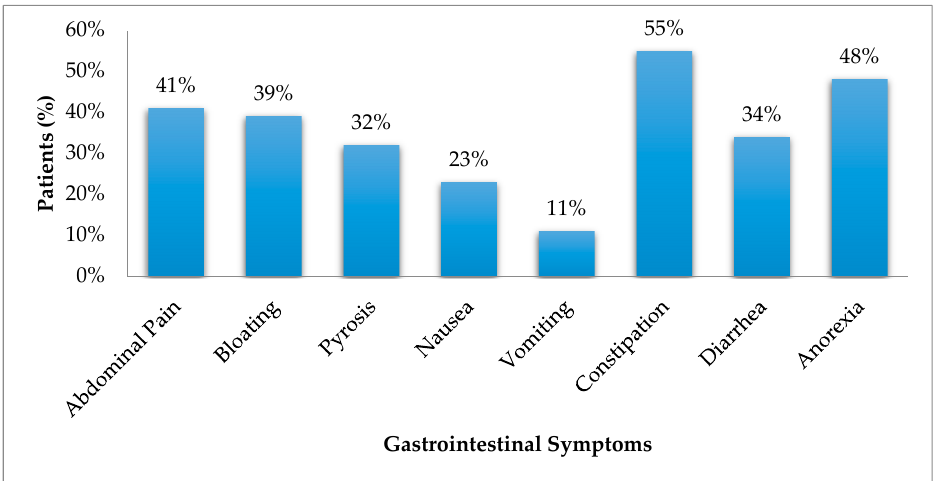
Figure 2. Prevalence of GIS in patients older than 60 years on dialysis.